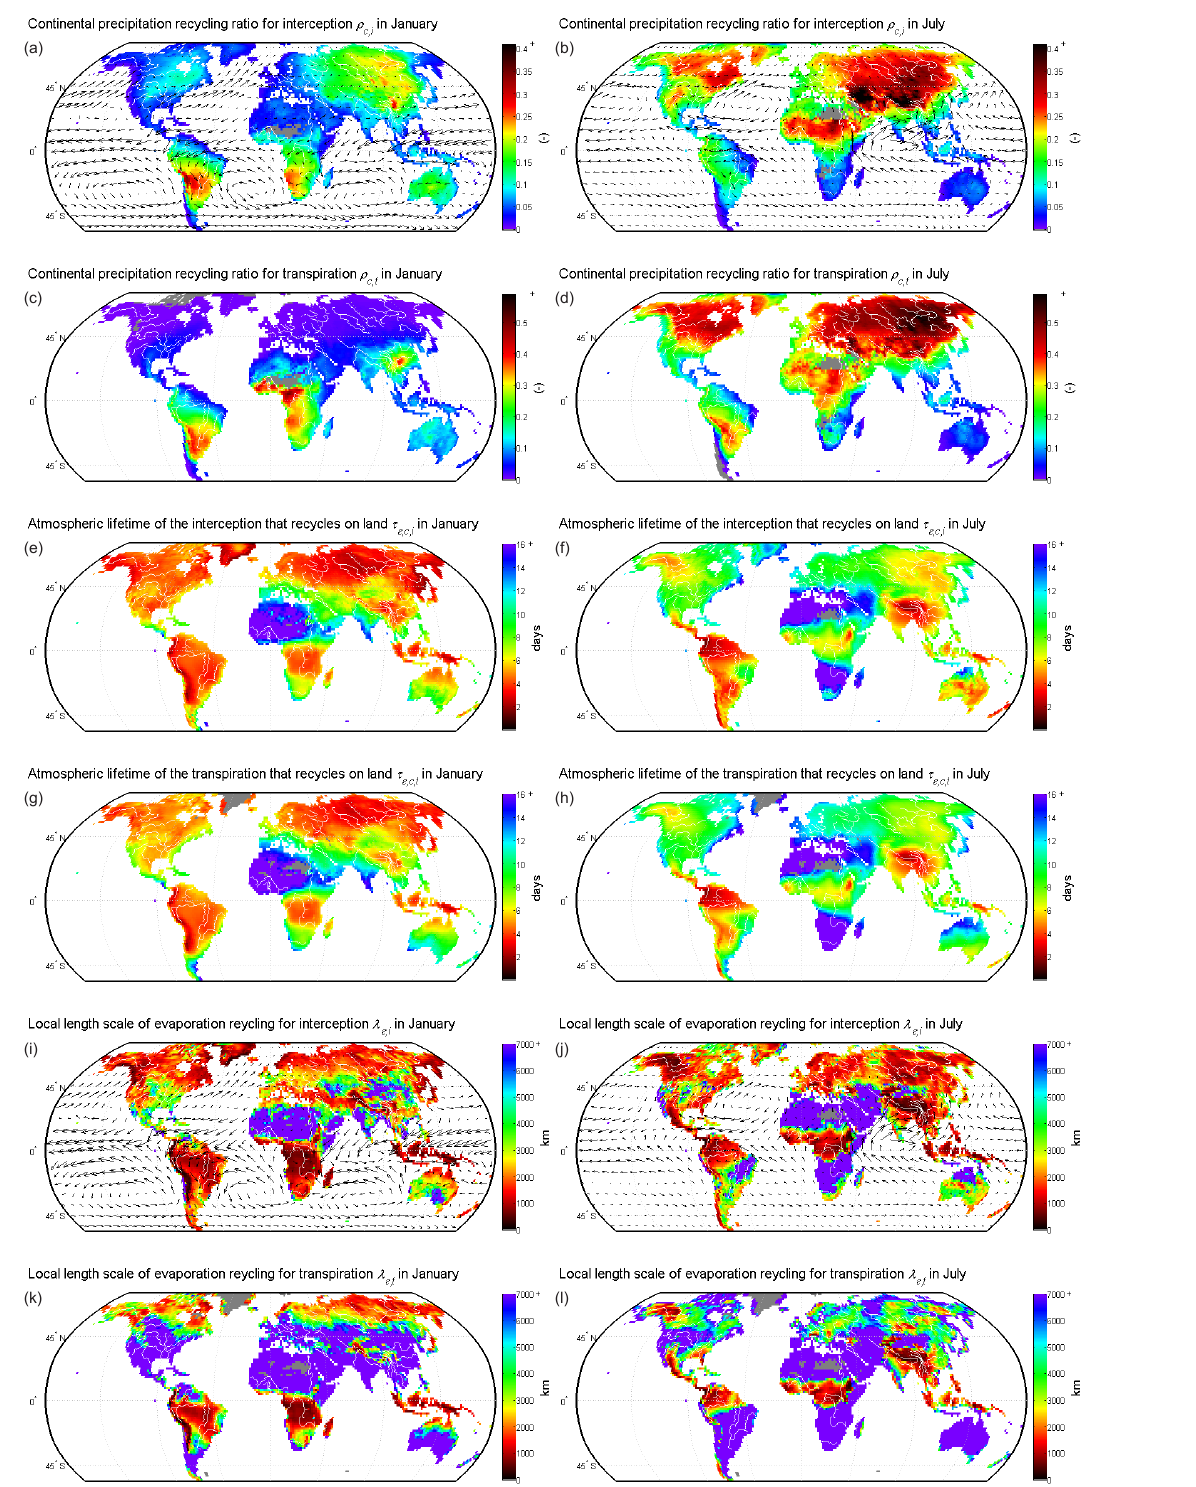
Figure 6. Moisture recycling metrics for January (left column) and July (right column). The arrows in (a) and (b) indicate the vertically integrated moisture fluxes, which are most relevant for panels (a–h) . The arrows in (i) and (j) indicate the moisture flux only in approximately the lowest 2km of the atmosphere, which is most relevant for panels (i–l)